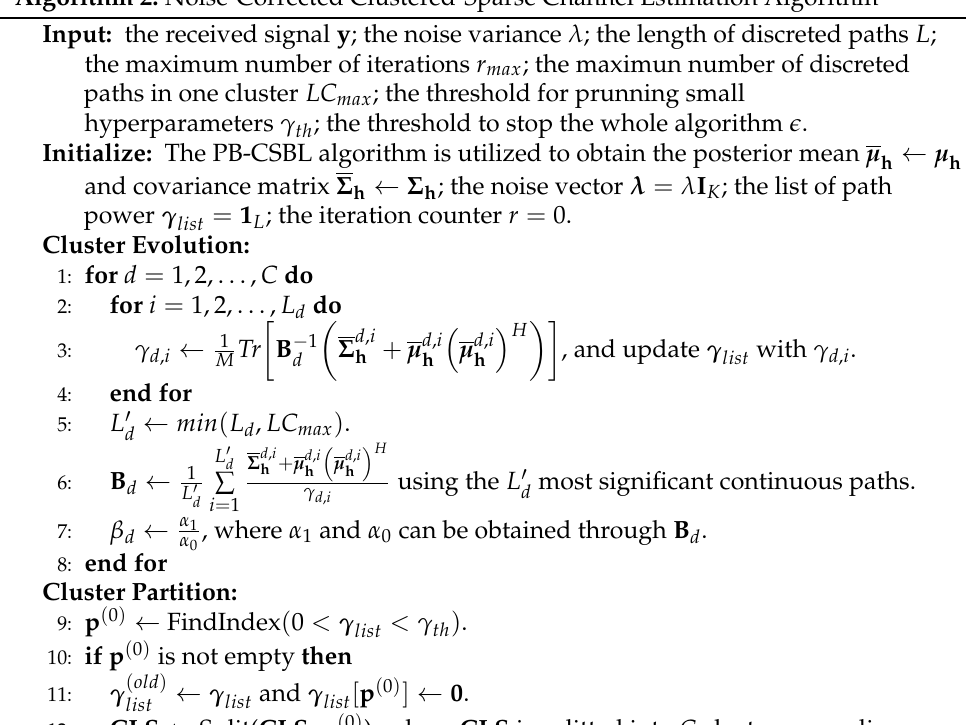
Algorithm 2: Noise-Corrected Clustered-Sparse Channel Estimation